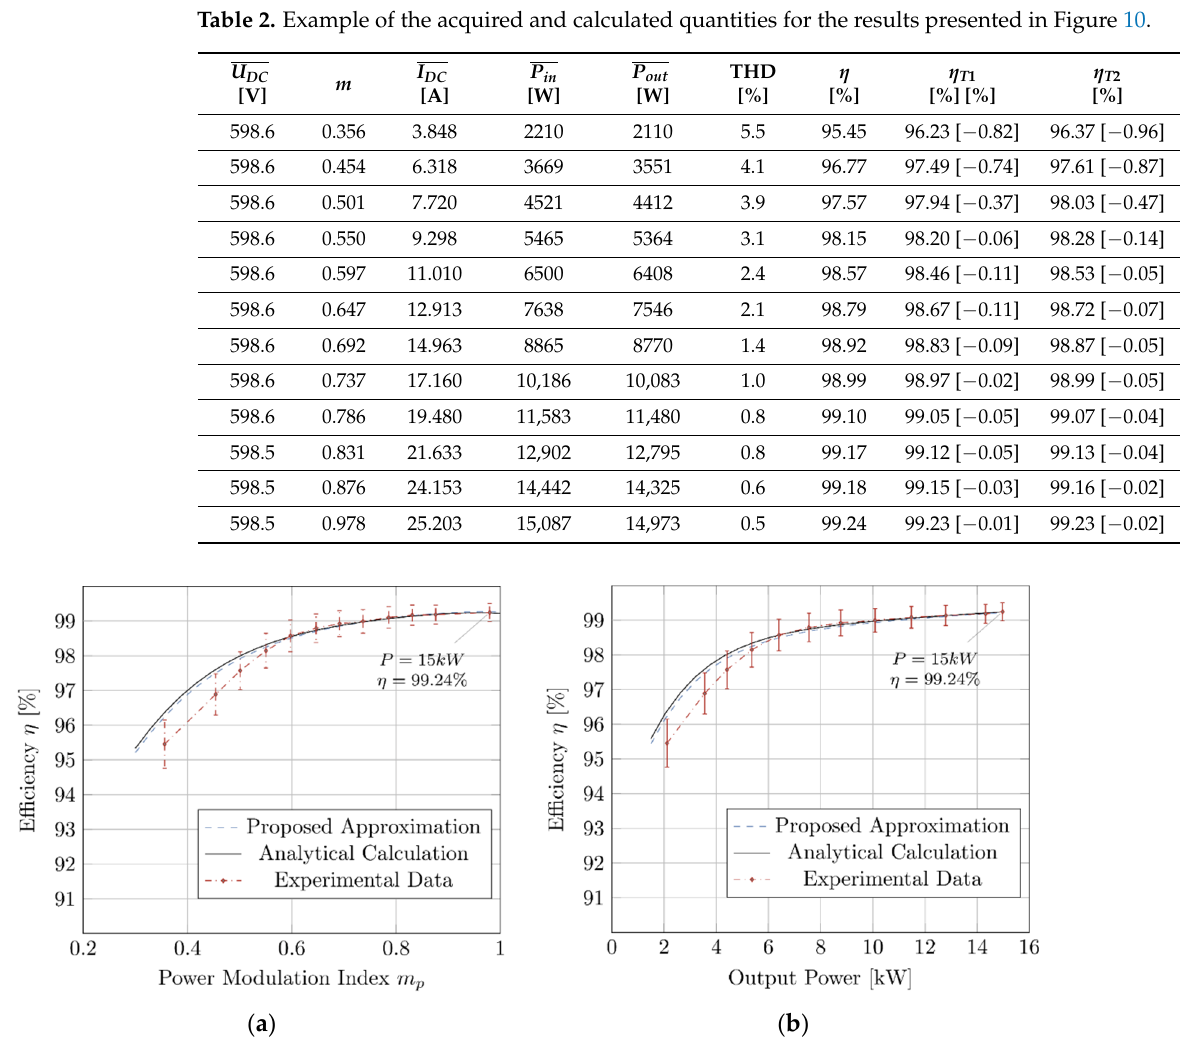
Figure 10. Efficiency vs. Power Modulation Index ( a ) and Output Power ( b ) comparison between experimental results (dashed) and analytical calculation.